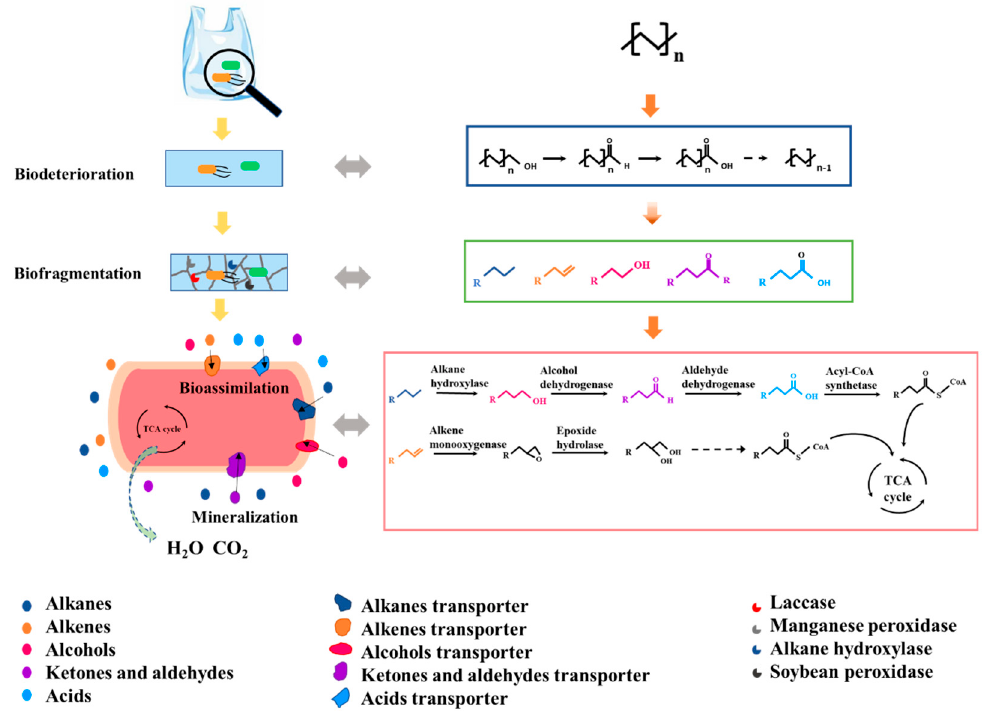
Figure 2. The process of PE biodegradation.